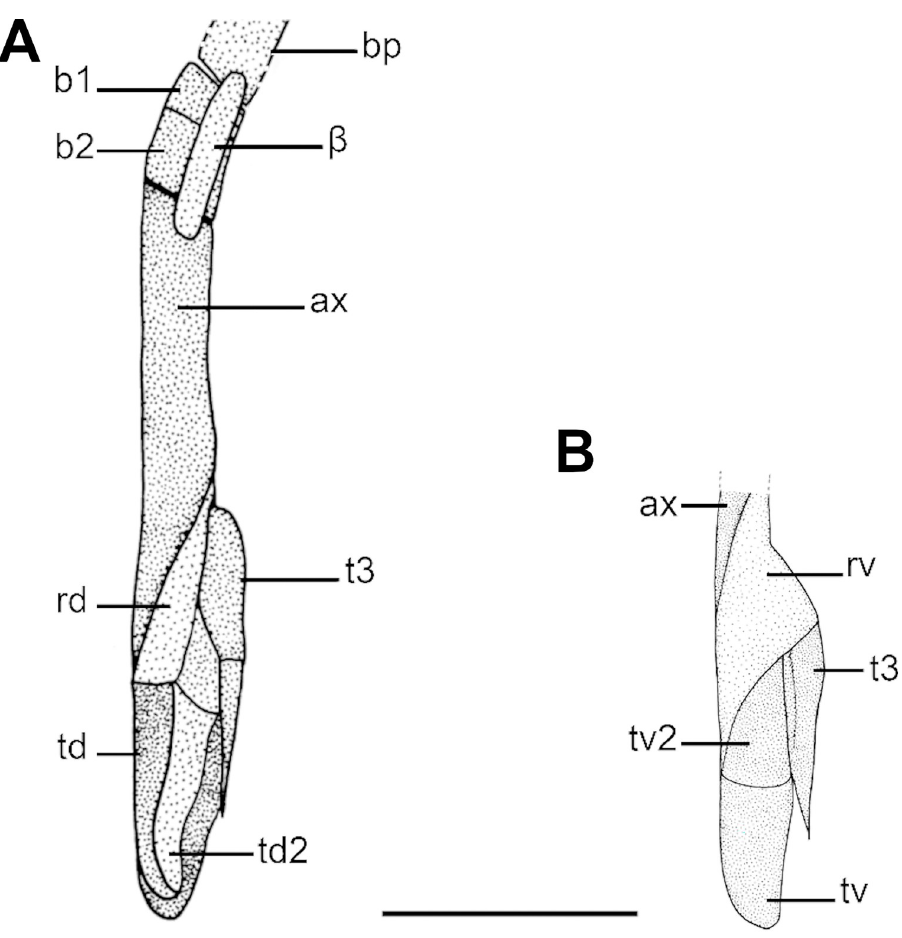
terminal 3 cartilage; β : beta cartilage. Scale bar: 10